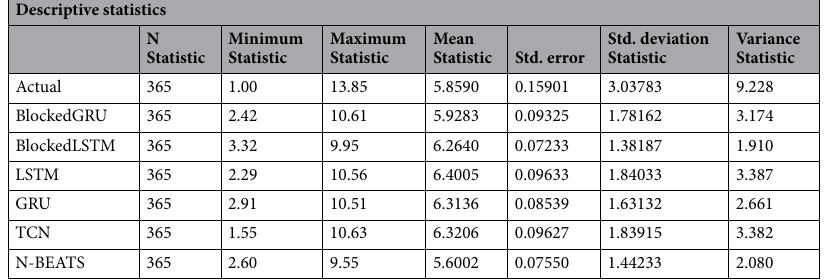
Table 4. Statistical analysis of the prediction results.